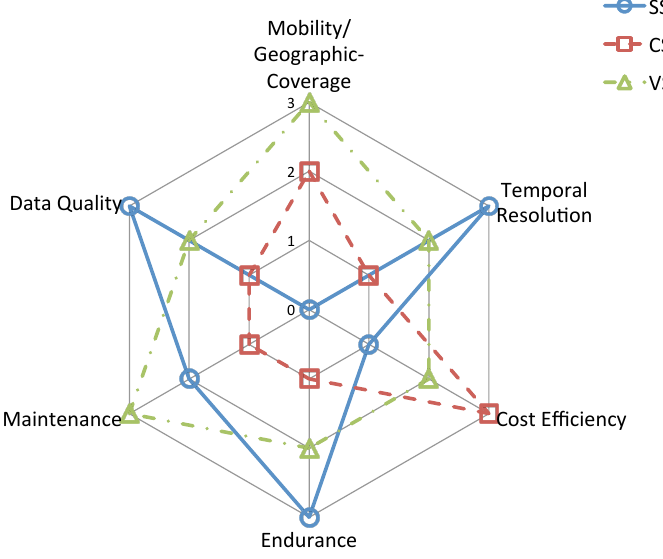
Figure 11. Grading result of the six major comparison properties in Static Sensor Network (SSN), Community Sensor Network (CSN) and Vehicle Sensor Network (VSN) (‘0’ means ‘None’; ‘1’ means ‘Low/Short/Inconvenient’; ‘2’ means ‘Medium’ and ‘3’ means